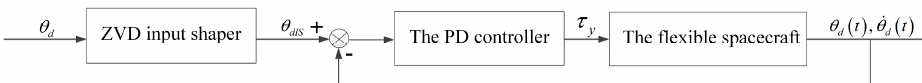
Figure 14. Block diagram of the PD + IS